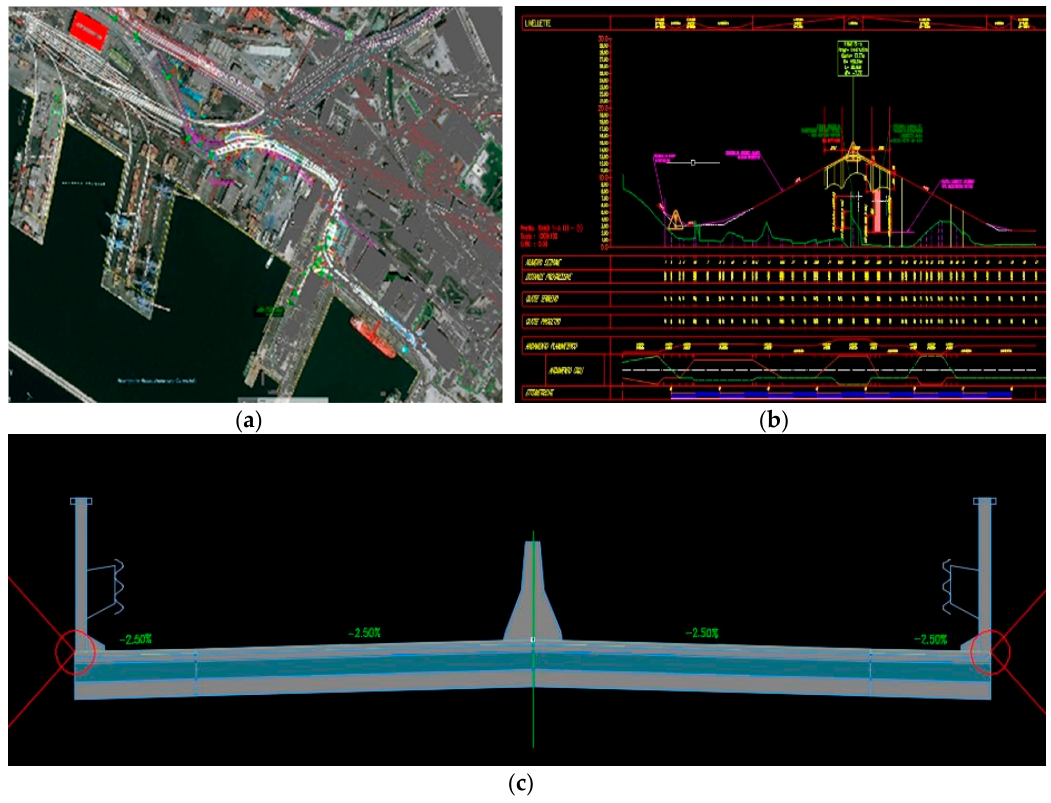
Figure 4. 3D road model: ( a ) horizontal alignment; ( b ) vertical alignment; ( c ) generic assembly template.